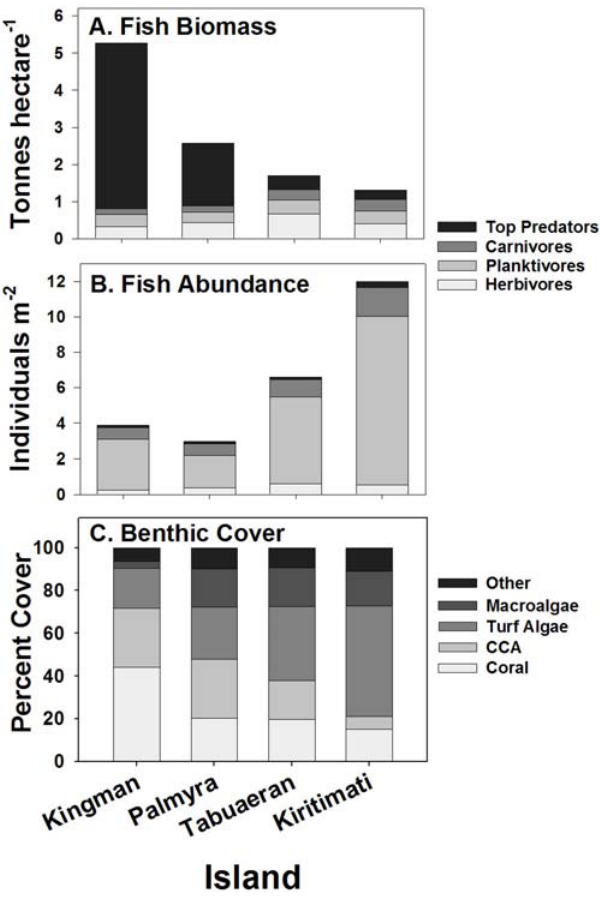
Figure 3. Fish biomass (A) and abundance (B), and cover of major benthic functional groups (C) across the northern Line Islands. Note that human impacts increase from left to right in this and subsequent figures. CCA=crustose coralline